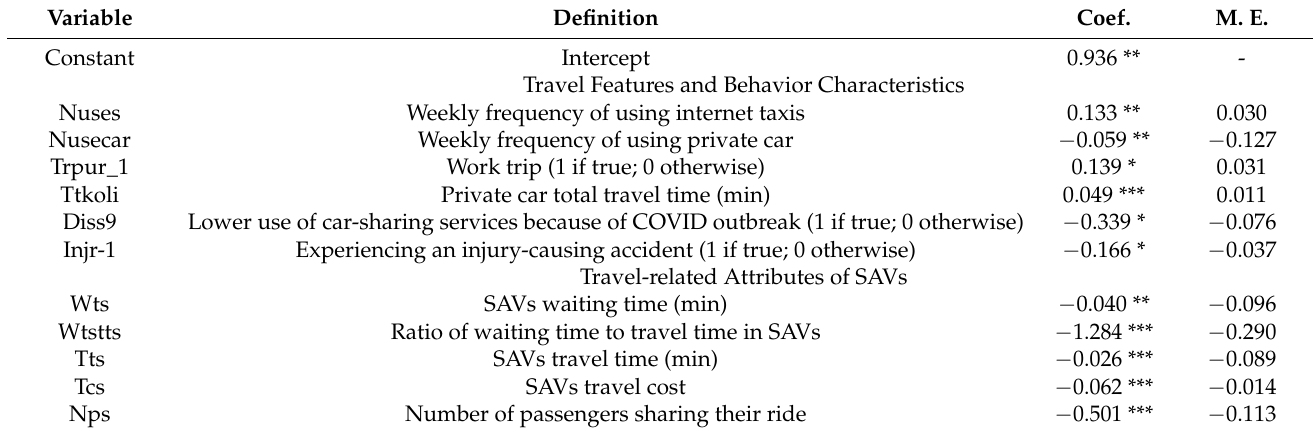
Table 8. Estimation results of binary logit model of modal shift preference of car